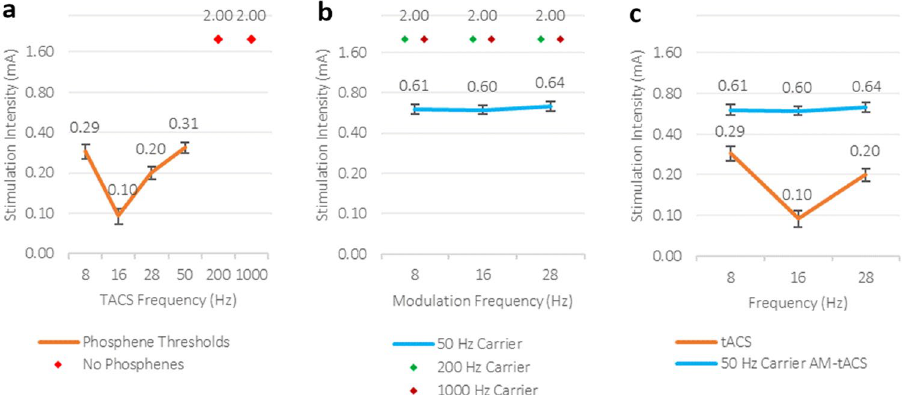
Figure 2. (a) Phosphene thresholds for all tACS conditions (8 Hz, 16 Hz, 28 Hz, 50 Hz, 200 Hz, 1000 Hz). Conditions form a V-shaped relation, with 16 Hz needing the least stimulation intensity to induce phosphenes. The 200 Hz and 1000 Hz stimulation did not induce phosphenes and were therefore set to the maximum stimulation intensity of 2 mA. (b) Phosphene thresholds for all AM-tACS conditions; 50 Hz carrier conditions (50 × 8, 50 × 16, 50 × 28), 200 Hz carrier conditions (200 × 8, 200 × 16, 200 × 28) and 1000 Hz carrier conditions (1000 × 8, 1000 × 16, 1000 × 28). Phosphene thresholds for the 50 Hz carrier conditions were similar across modulation frequencies. None of the 200 Hz and 1000 Hz carrier conditions induced phosphenes and therefore reached the maximum stimulation intensity of 2 mA. (c) Phosphene thresholds for AM-tACS modulation frequencies of 50 Hz carrier conditions (50 × 8, 50 × 16, 50 × 28) and corresponding tACS conditions (8 Hz, 16 Hz, 28